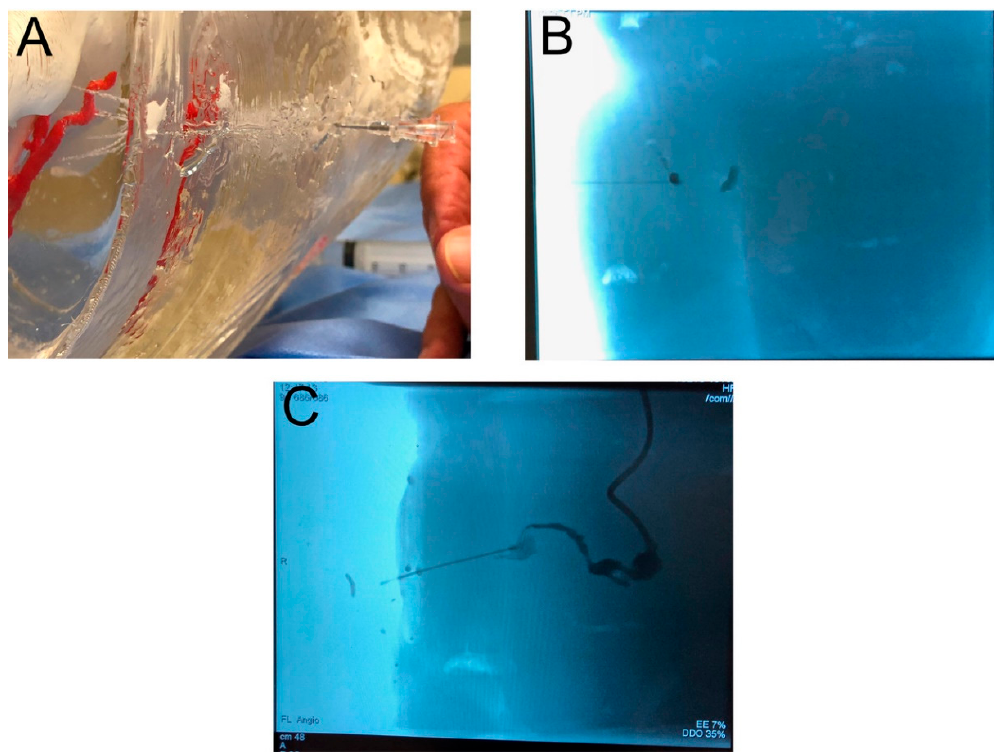
Figure 5. Needle puncture procedure. ( A ) View of puncturing 3D silicone model ( B) Gluteal artery needle puncture under fluoroscopy ( C ) Gluteal artery filled with contrast.